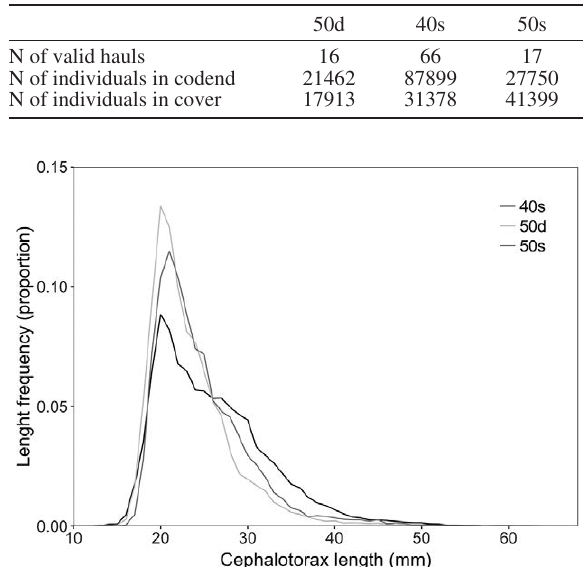
Fig. 3. – Length frequency of individuals encountering the gear in the experimental tows for the three mesh configurations: 50-mm diamond (50d), 40-mm square (40s) and 50-mm square (50s).